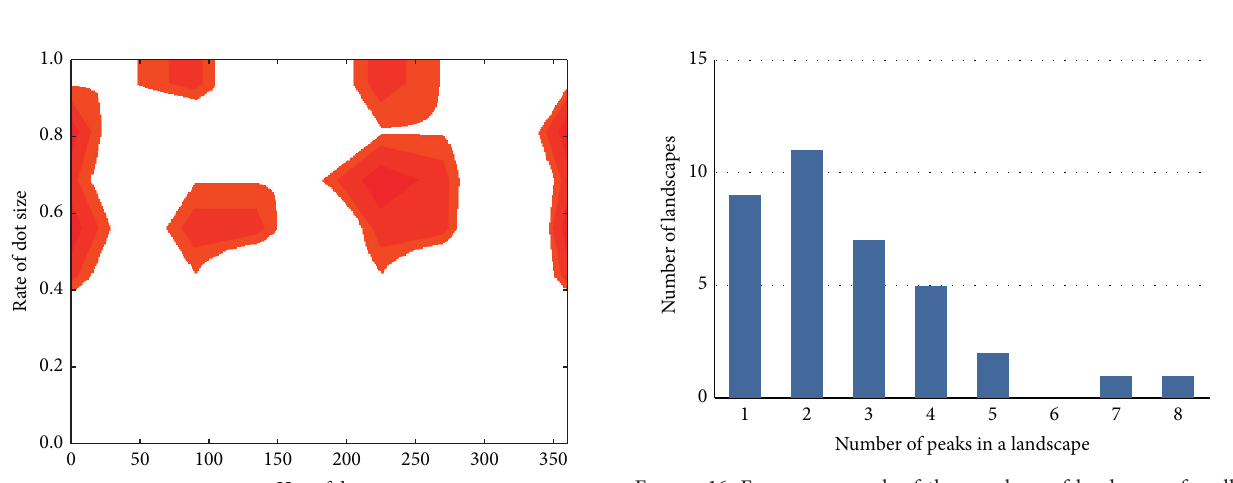
Figure 16: Frequency graph of the numbers of landscapes for all number of